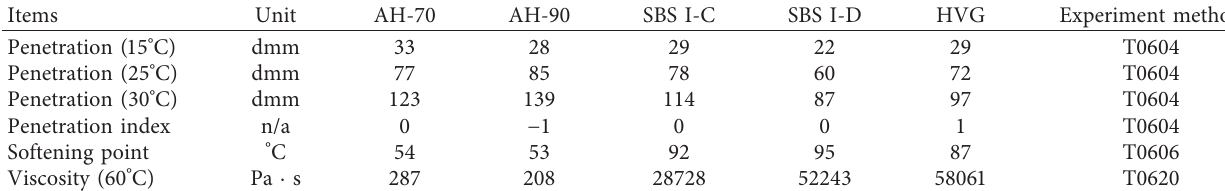
Table 1: Properties of unaged